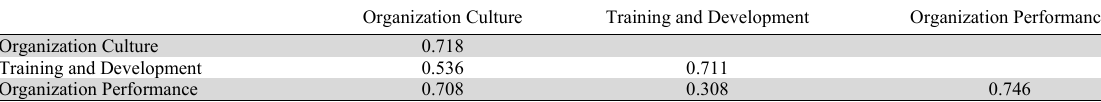
Fornell-Larcker Criterion